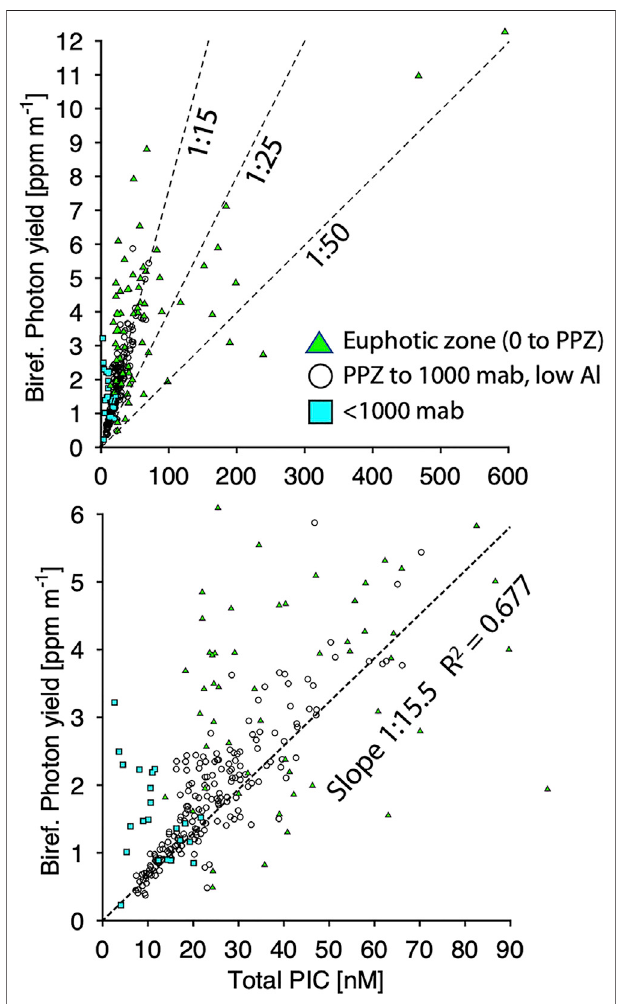
FIGURE 9 | Plots of birefringent photon yield [ppm m -1 ] from PIC011 vs. PICmeasured inpumpsamplesfromthesamedepth.Upperplotdenotesthe full range of data; the lower plot is magni fi ed. Data from the surface to the depth of the euphotic zone (PPZ – de fi ned as depth where fl uorescence is 10% of maximum value) show a scatter in birefringence and PIC data with trends bracketed by slopes ranging from 1:7 to 1:50. Data for the water column below the PPZ depth extending to 2000 m are correlated with a slope of 1:15.4 and R 2 = 0.677. The regression excluded the region from 2000 m to 1000mabovesea fl oorasthesedatawereusedtosetthepressurecoef fi cient of the sensor. Data within 1000 m of the sea fl oor both follow the midwater trendbutalso divergetohighpositivebirefringence values.Cases ofindividual pro fi les are shown in Figure 10